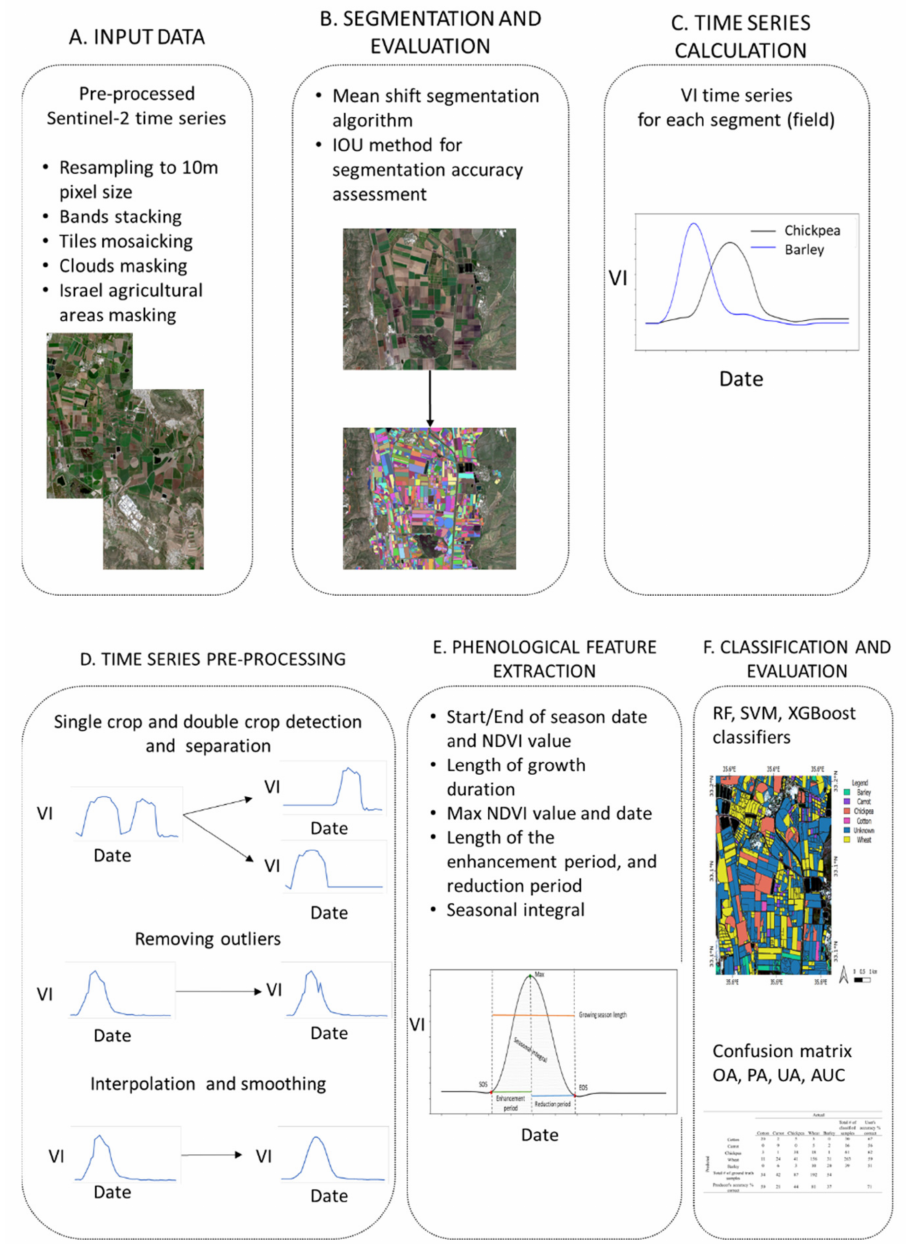
Figure 2. The workflow of the crop classification